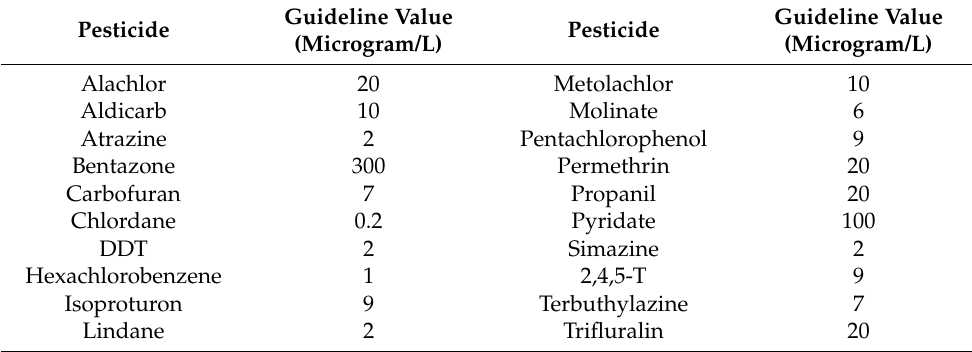
Table 3. Guideline value of pesticide level in drinking water